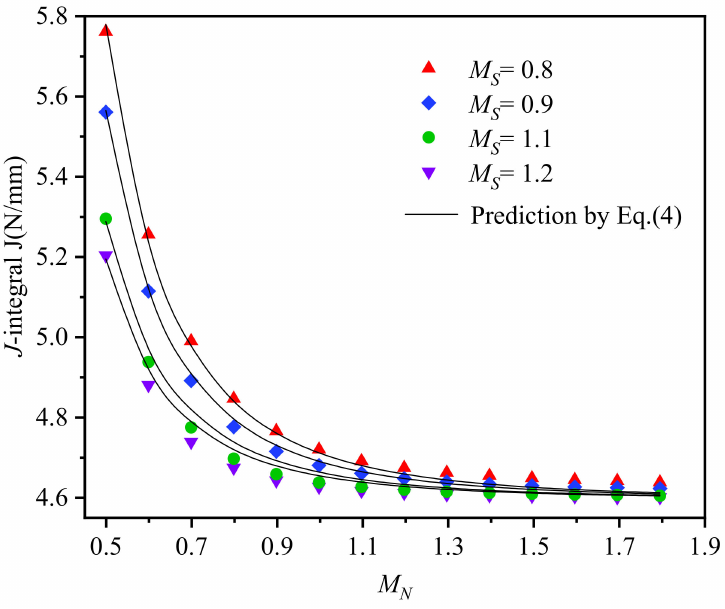
Figure 10. Comparison between the FEA results and predicted J